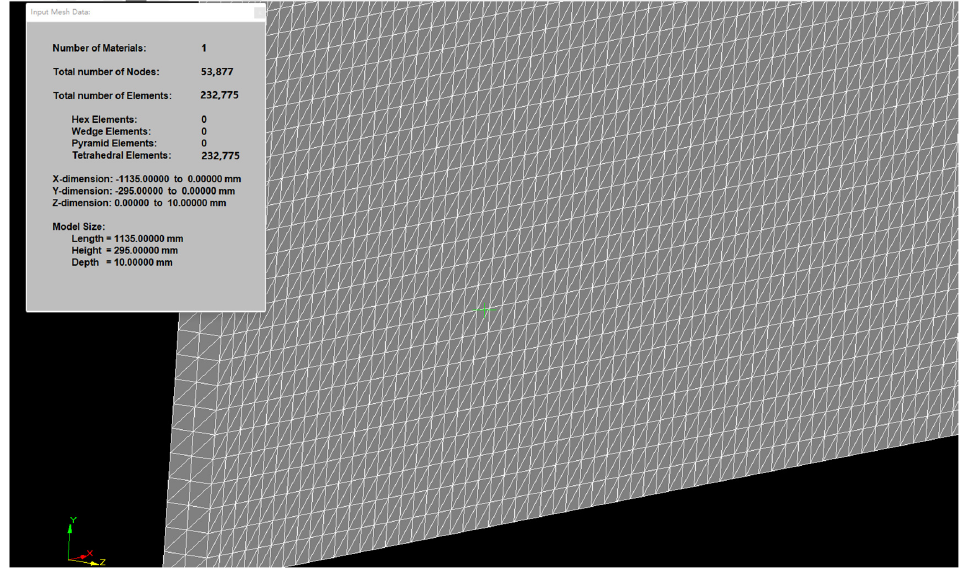
Figure 1. Information about geometric